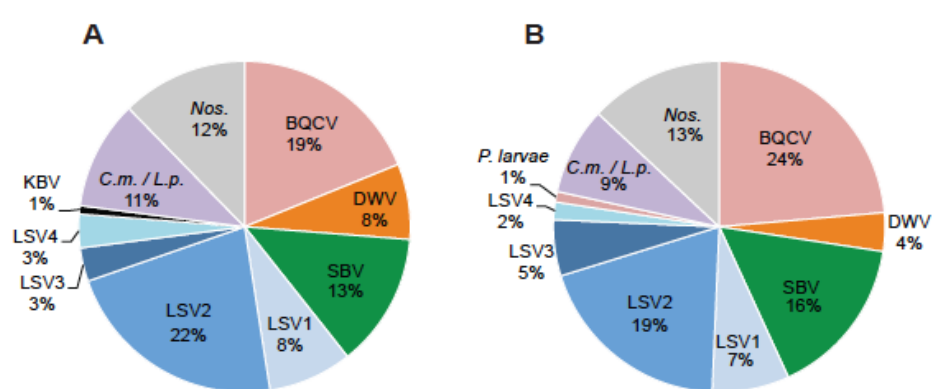
Figure 1. Distribution of honey bee pathogens detected in weak and strong colonies. Honey bee samples were obtained from 54 monitor colonies from October 2013 to June 2014. PCR was used to test for 16 honey bee infecting pathogens including: viruses (ABPV,